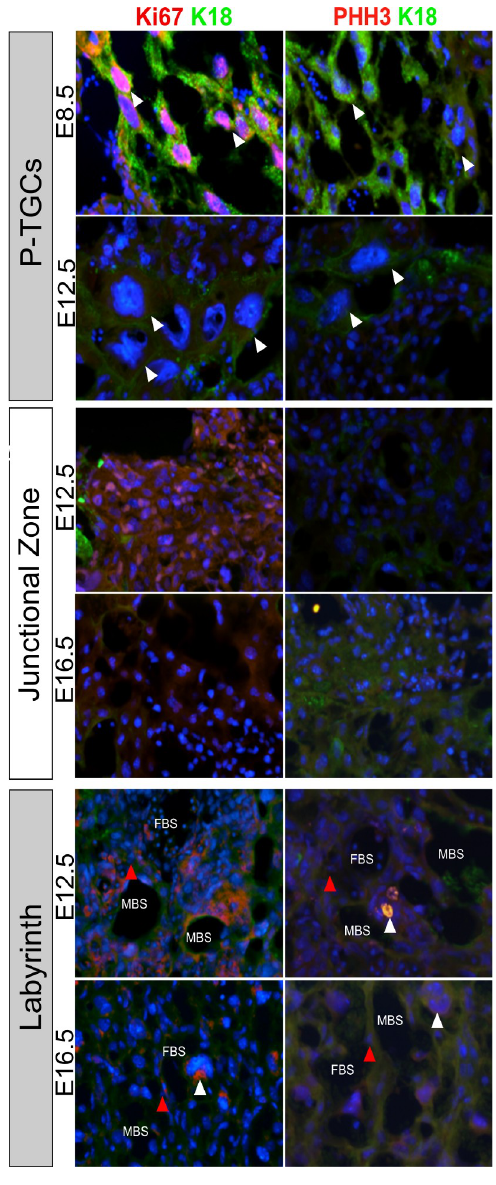
Fig 2. Ki67 and Phospho-histone H3 immunofluorescence staining in P-TGCs, junctional zone and labyrinth. Histological sections were dual stained for Ki67/K18 (red/green respectively) or phospho-histone H3/K18 (red/green respectively) and nuclei are counterstained with DAPI (blue). Phospho-histone H3 was detectable at E12.5 in sinusoidal-TGCs within the labyrinth (white arrow; x400 magnification in the inset) but not in SynT cells (red arrow). MBS–maternal blood space; FBS–fetal blood